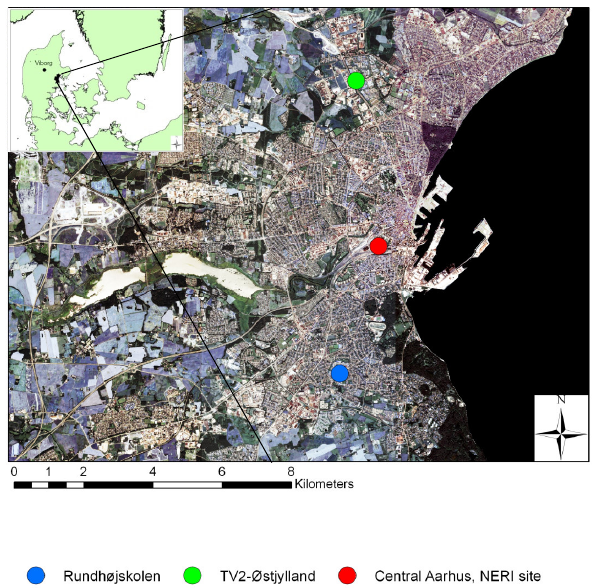
Fig. 2. Municipality of Aarhus, Denmark and location of the three pollen traps in Aarhus and the operational trap in Viborg (upper